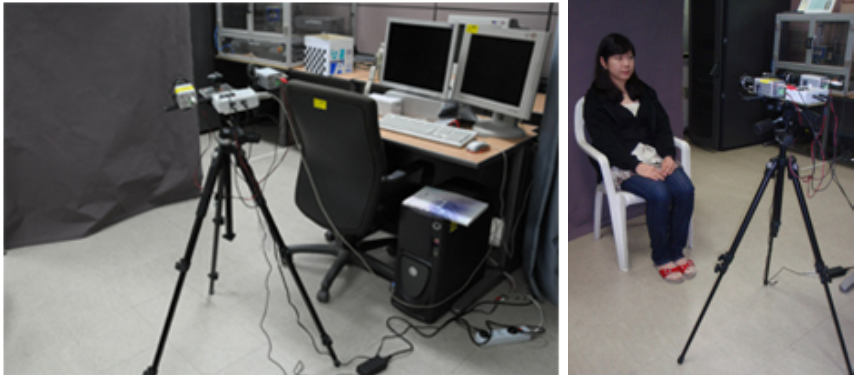
Figure 15. Proposed system and experiment